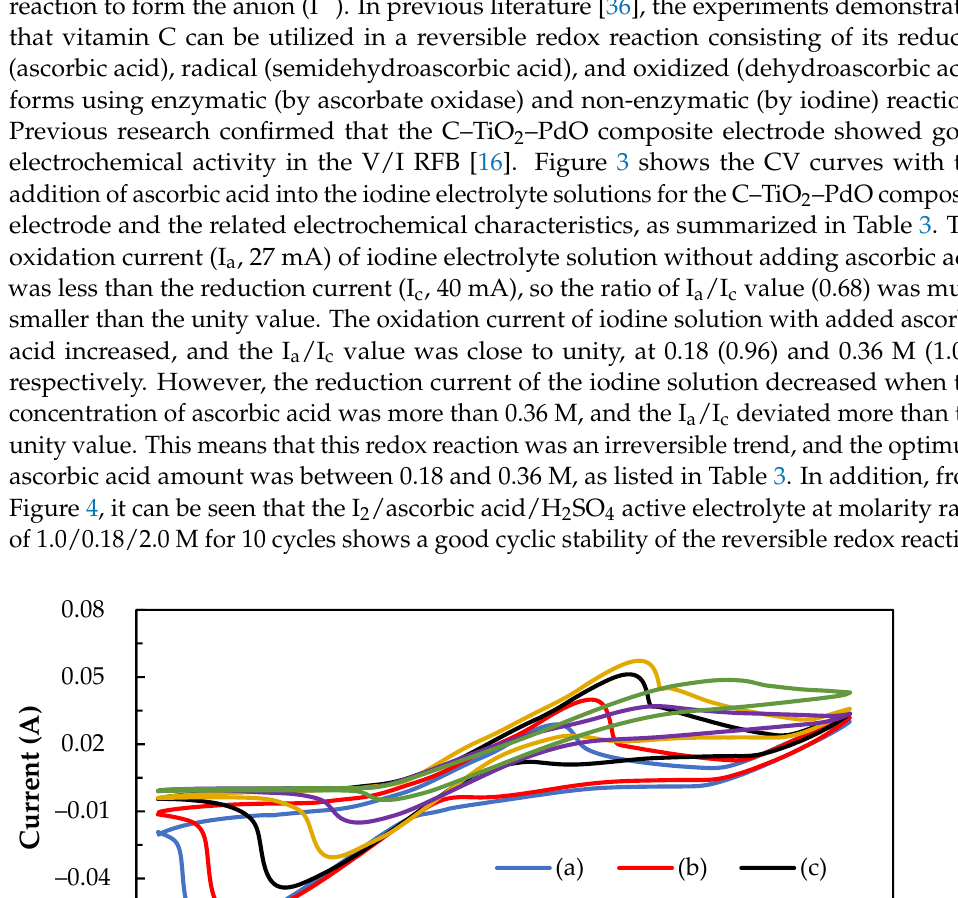
acid/H 2 SO 4 active electrolyte ( a ) 1.0 / 0.0 / 2.0 M (without ascorbic acid) ( b ) 1.0 / 0.18 / 2.0 M ( c ) 1.0 / 0.36 / 2.0